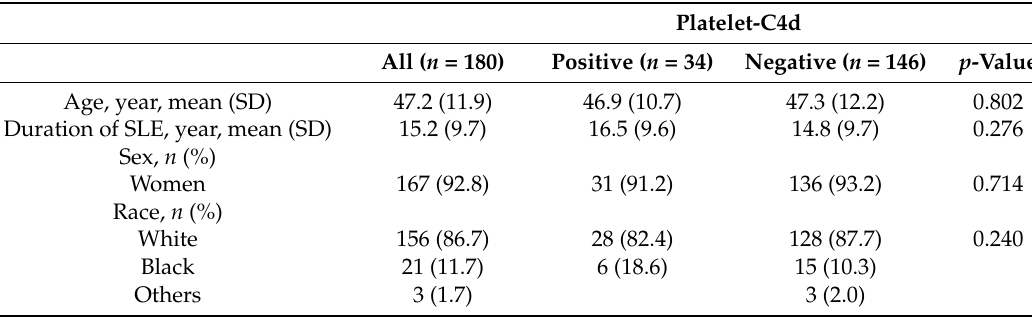
Table 1. Patient demographics and clinical